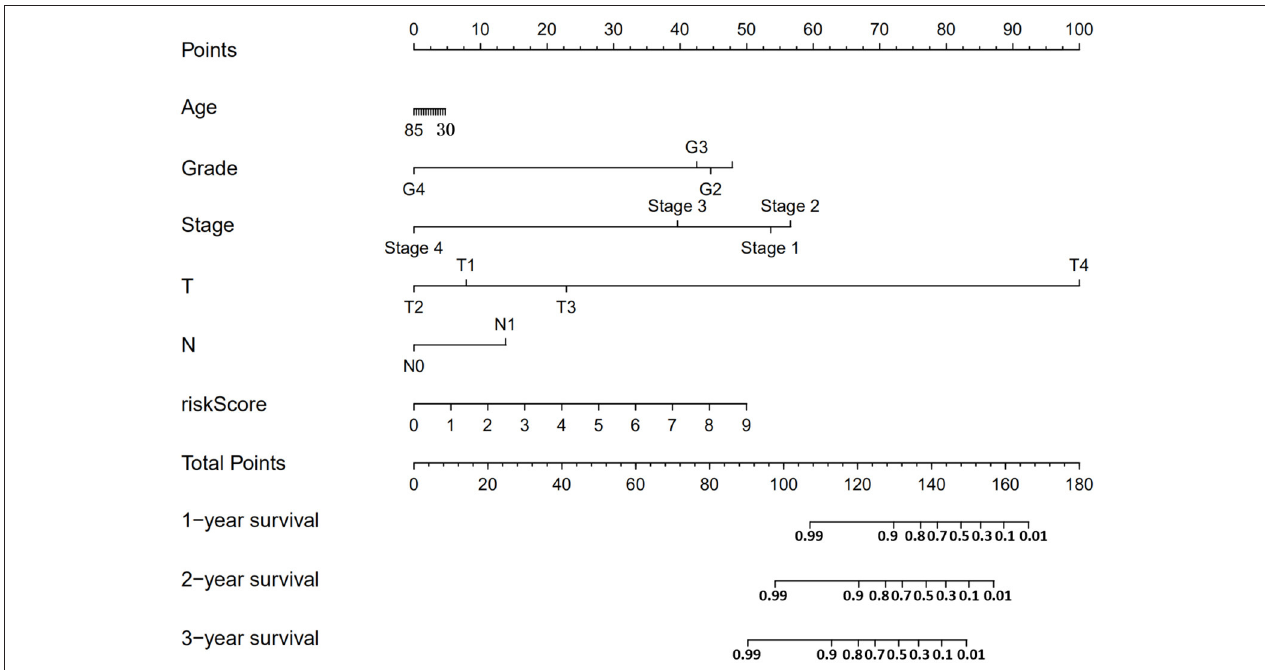
FIGURE 7 | Nomogram can predict the 1,3, and 5 year overall survival of patients with CESC.